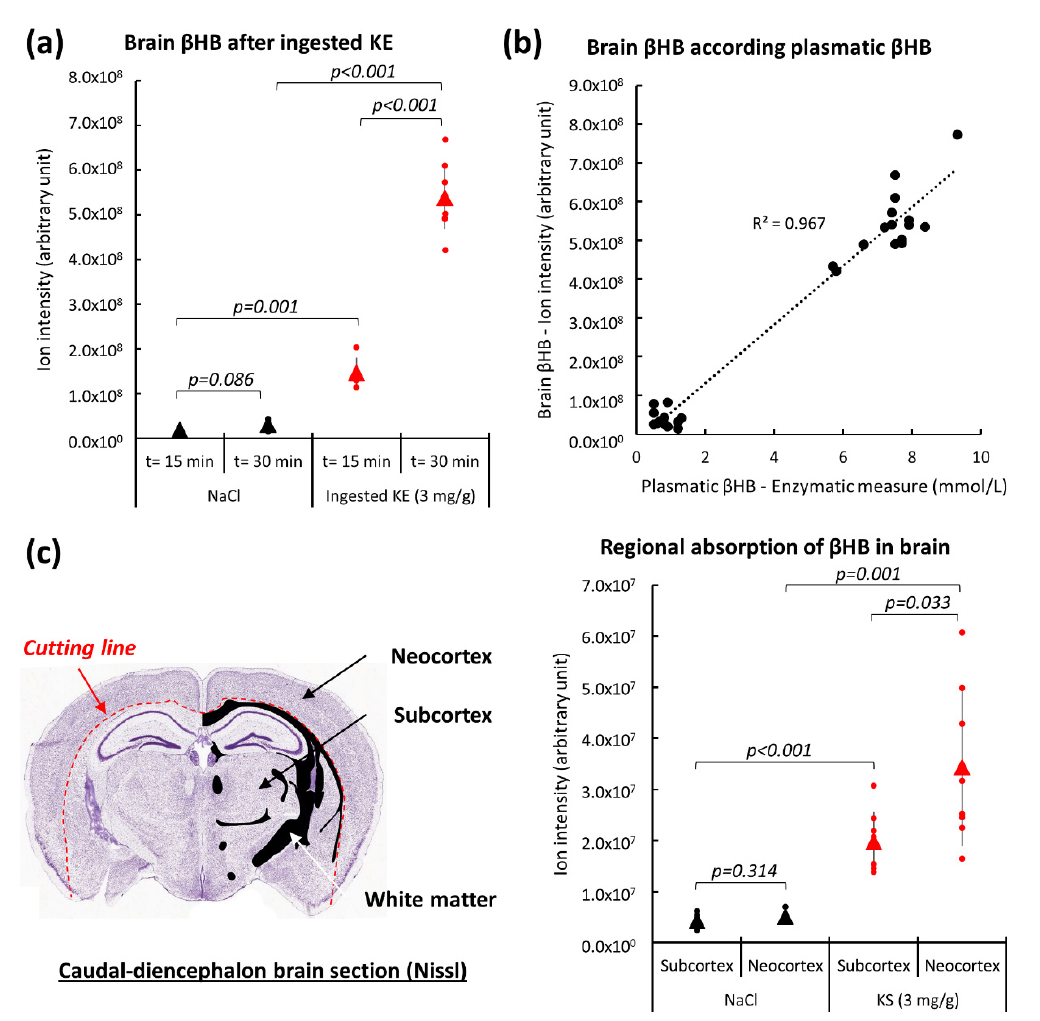
Figure 4. Brain β HB levels after KE ingestion. LC-MS analyses of brain β HB levels at 15 min and 30 min after intake of 3 mg KE/g of body weight and 0.9% NaCl (n = 10) ( a ). Brain β HB levels at different plasma β HB concentrations (n = 10) ( b ). Regional brain β HB levels 15 min after IP injection of 3 mg ketone salt/g of body weight (n = 8). LC-MS analyses were conducted on frozen sections after separation (red dotted line) of neocortex (grey matter) from the subcortex (grey and white matter) region using microdissection as specified on the cutting plane above ( c